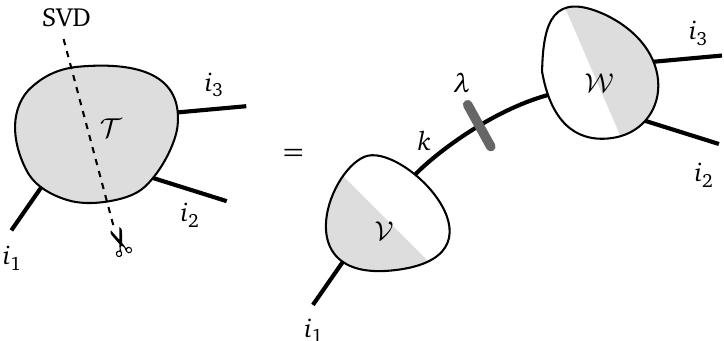
Figure 9: QR decomposition and isometry. (a) We split T at the dashed line into R and an isometry Q via QR-decomposition. (b) The isometry is depicted by a gray- white filling: the gray partition indicates the links over which we have unitarity. In other words, the link index k at the opposite partition enumerates an orthonormal (cid:0) (cid:1) = Q q k set of d vectors . k k ( i 1 ... i r ) ( i ) 1 ... i r